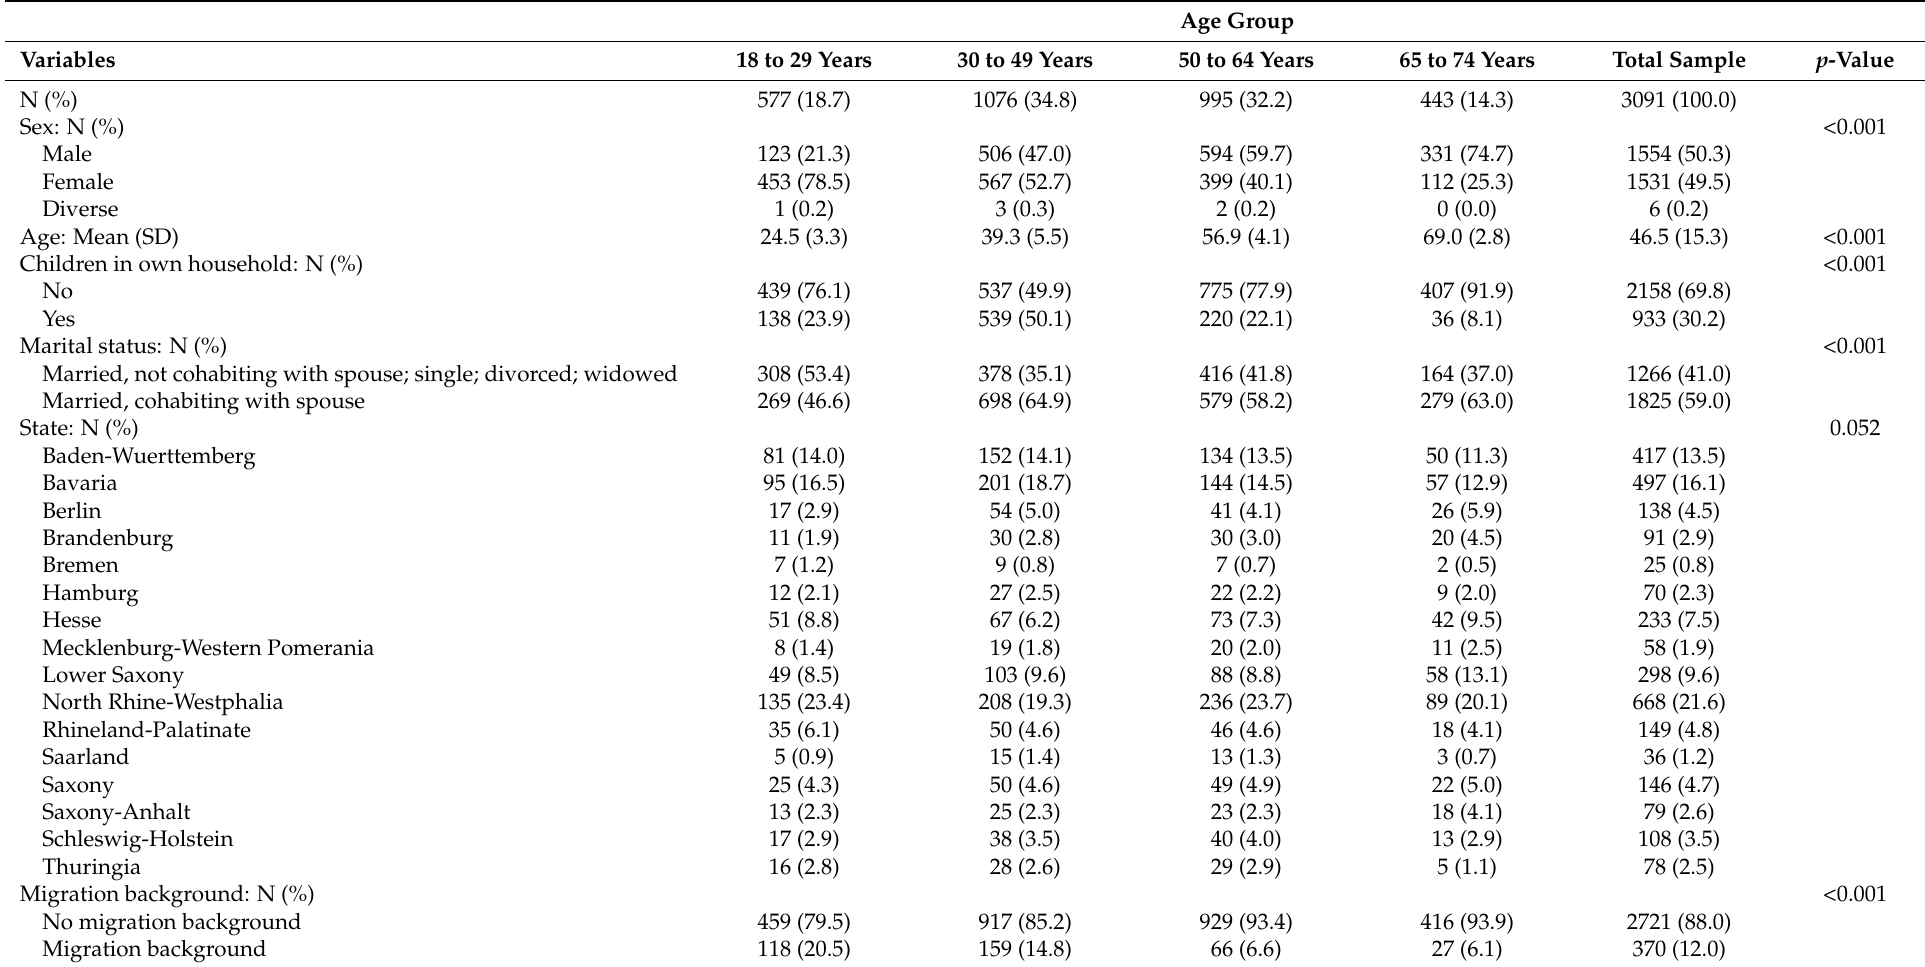
Table 1. Sample characteristics for the total sample (n = 3091) and stratified by age